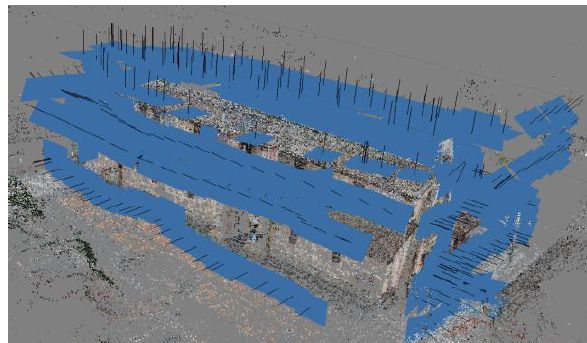
Figure 7 . Nabón’s church sparse point cloud